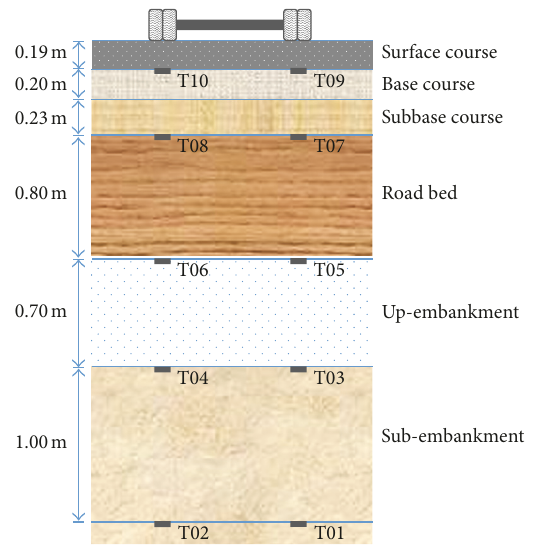
Figure 3: Location and placement of soil pressure cells (units: m). The dynamic soil pressure cells (BY-1) used in the field tests were produced by Dandong Qiulong Sensor Manufac- turing Co., Ltd. The measurement range of the sensor was from 0 to 200 kPa and the sensitivity was 1 mv/v dimension.